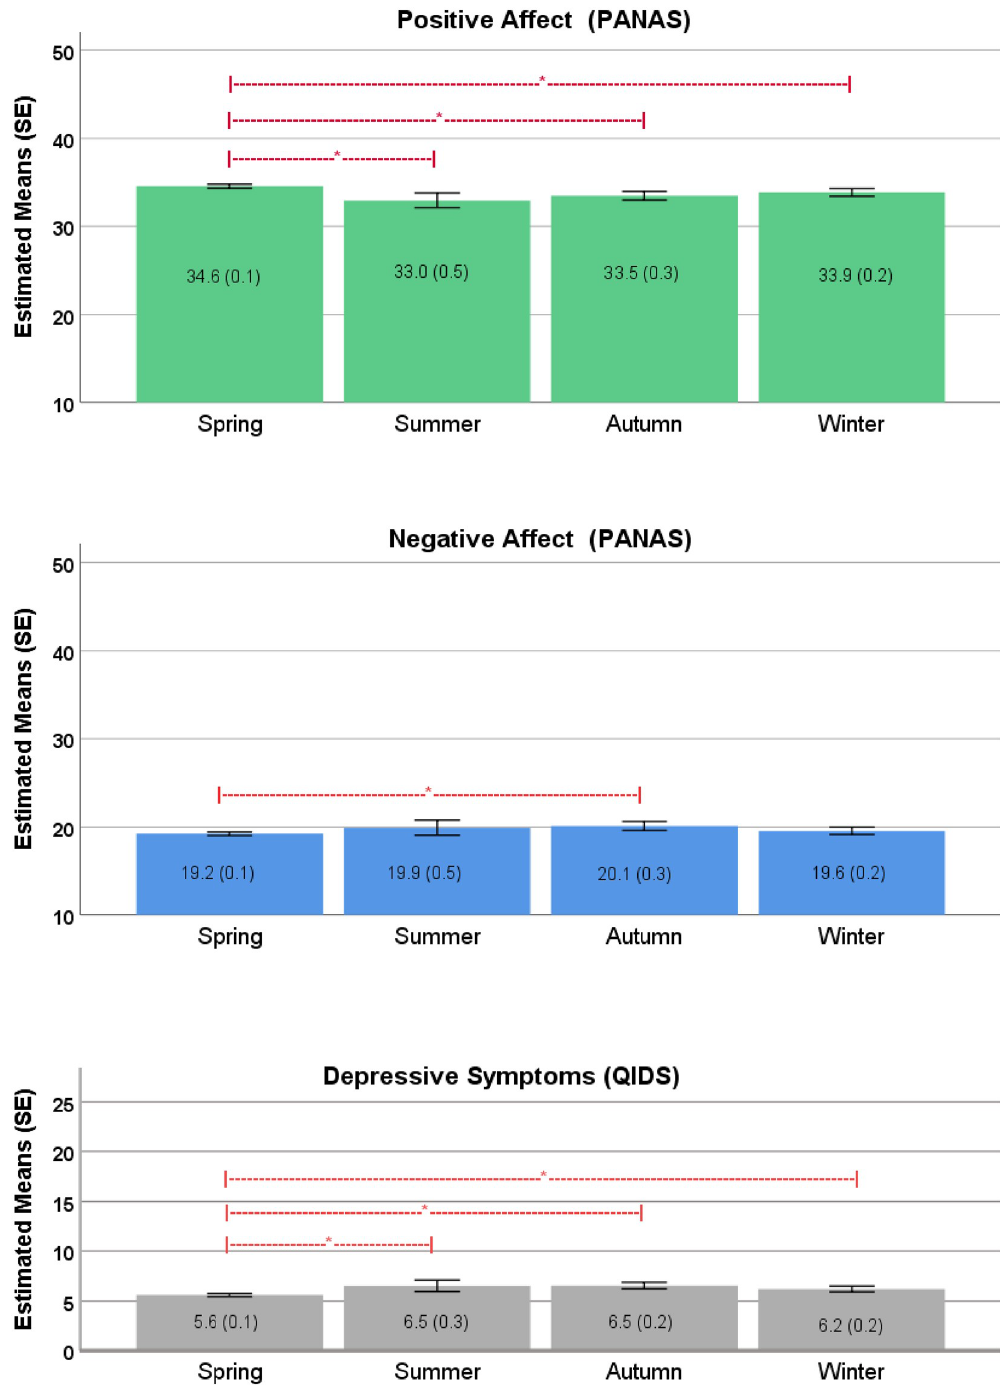
Fig 1. Positive and negative affect (PANAS) and depressive symptoms (QIDS) by season. Estimated means and standard errors (SE) based on 1000 bootstrap samples from ANCOVA models adjusted for age, gender, partner status, education, employment status, and